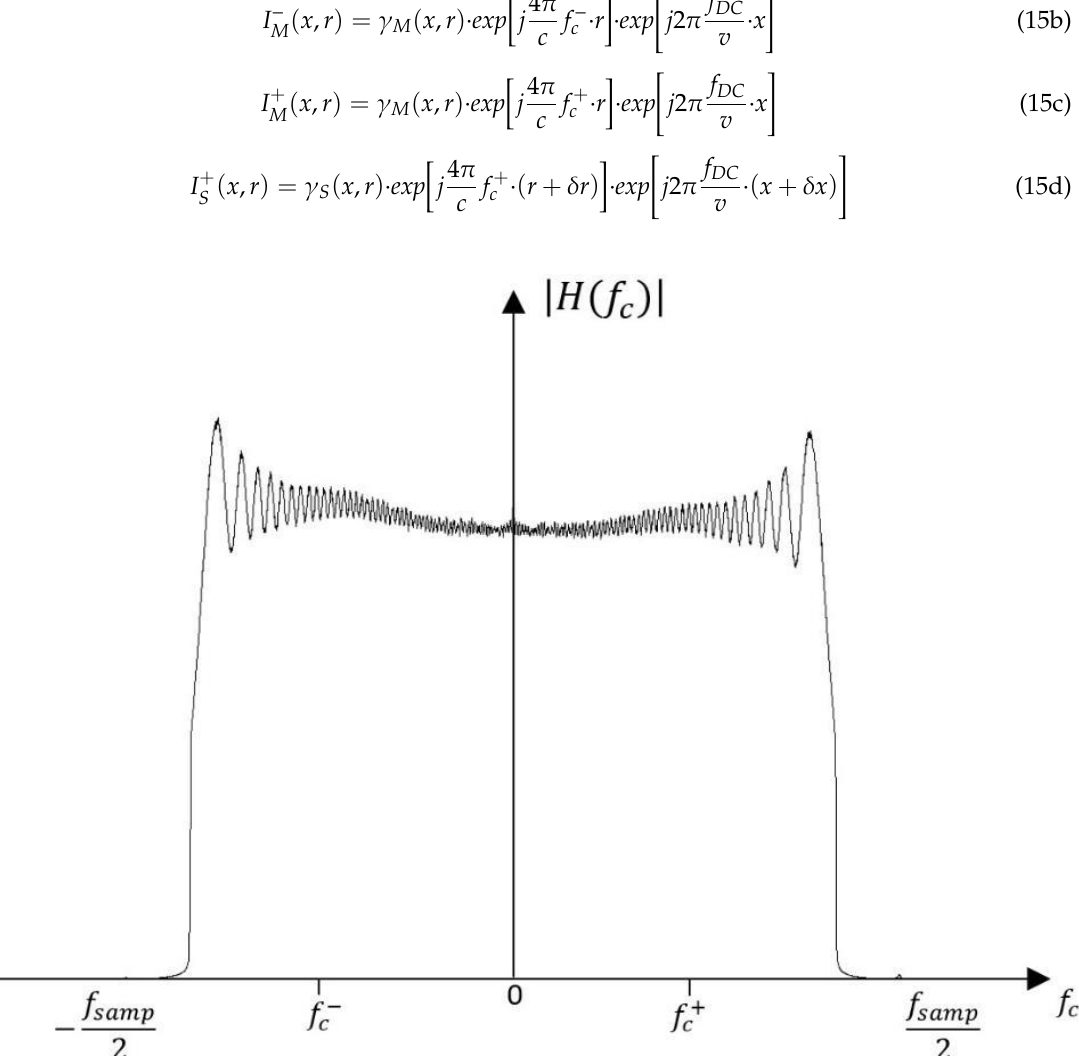
Figure 5. Sketch of the amplitude range spectrum ( 𝐻 𝑓𝑐 ) of a full-band SAR image, where 𝑓 𝑐− and 𝑓 𝑐+ indicate the low and the high range frequencies, respectively, and 𝑓 𝑠𝑎𝑚𝑝 is the sampling frequency.